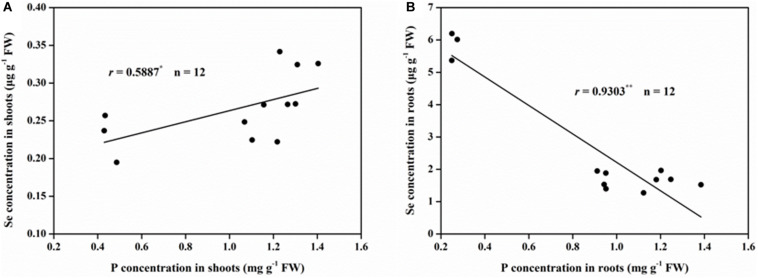
Correlations between Se and P concentration in rice (A) shoots and (B) roots. ∗Correlation is significant at P < 0.05; ∗∗Correlation is significant at P < 0.01.